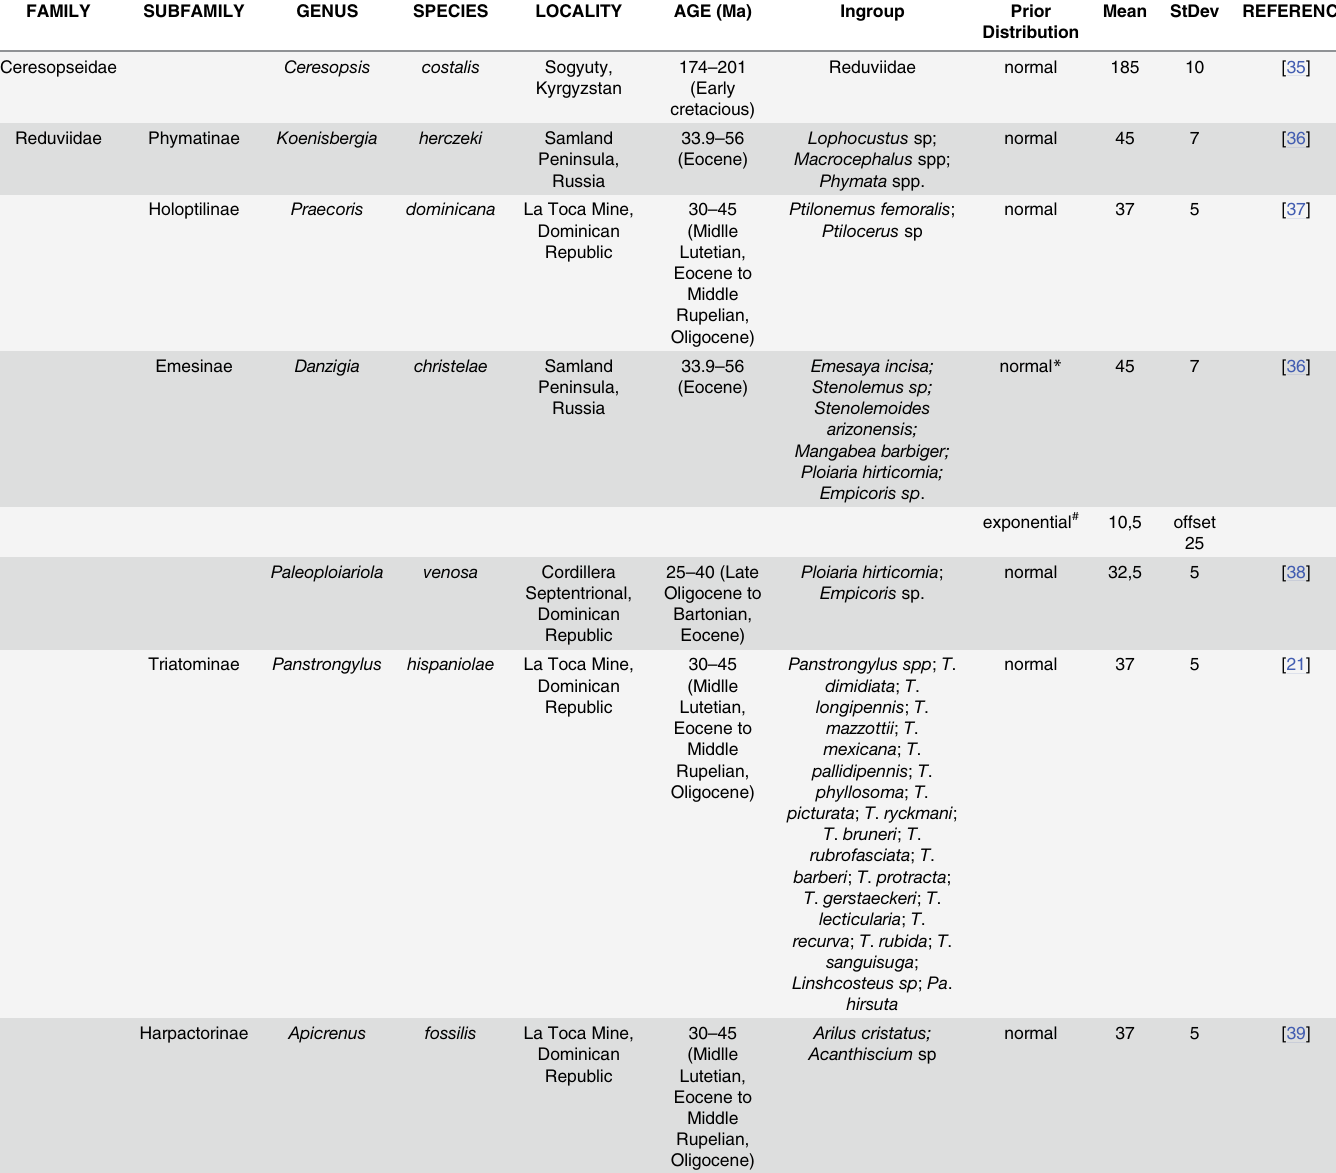
Table 1. Description of the age priors used in Bayesian inference for time diversification. * Prior distribution used in the analysis that included Paleo- ploiarola venosa; #Prior distribution used in the analysis that did not include Paleoploiarola venosa . Triatoma dominicana has the same estimated age as Pan- strongylus hispaniolae . Therefore, Panstrongylus hispaniolae was the only Triatominae fossil included.